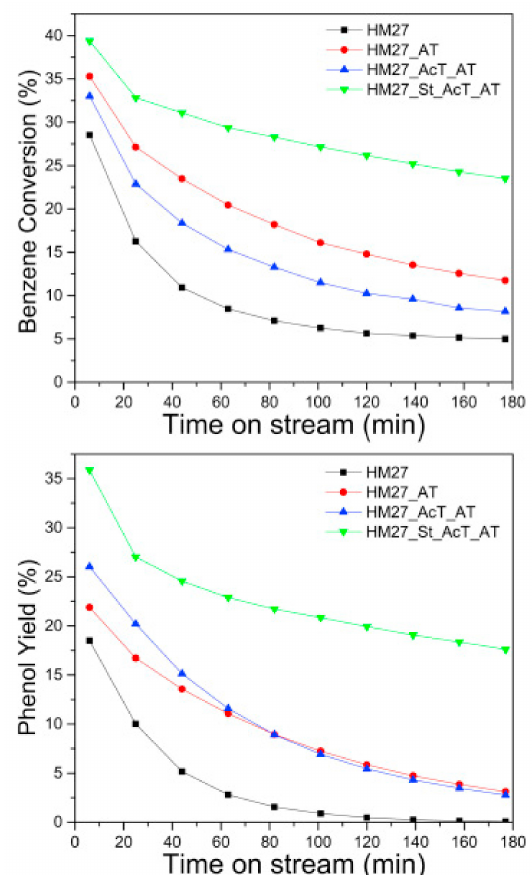
Figure 26. Benzene conversion and phenol yield with time on stream. Reproduced with permission from Reference [67]. Copyright (2016) Elsevier B.